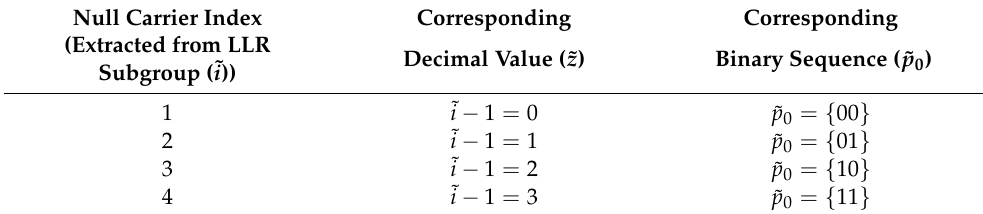
Table 2. The proposed scheme index demodulator ( (cid:101) M = 4). Null Carrier Index Corresponding Corresponding (Extracted from LLR Decimal Value (˜ z ) Binary Sequence ( ˜ p 0 ) Subgroup (˜ i ))